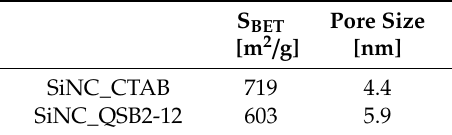
Table 2. Textural properties of SiNC_CTAB and SiNC_QSB2-12.